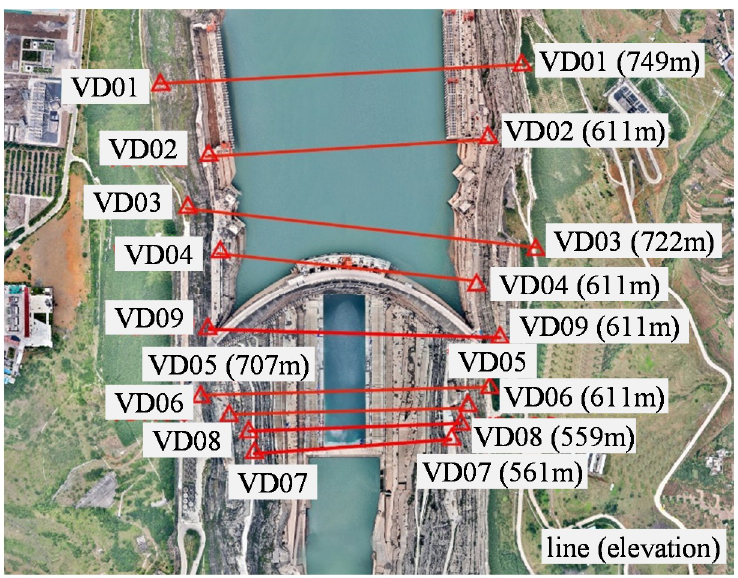
Figure 3. Locations of the monitoring lines of the river valley contractions (RVCs) at the Xiluodu Dam. Most valley deformation monitoring lines began in December 2012, except for VD09,